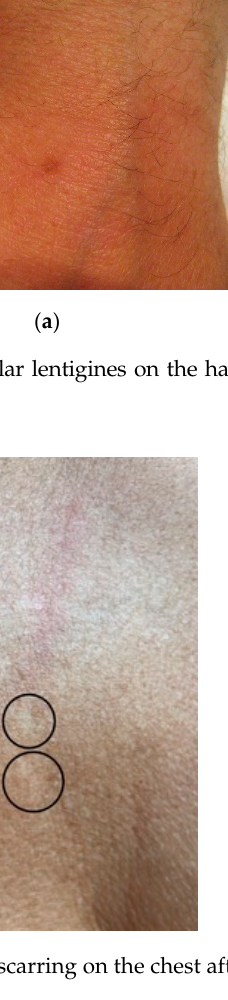
Figure 1. ( a ) Solar lentigines on the face, before treatment, ( b ) solar lentigines on the face, after treatment.